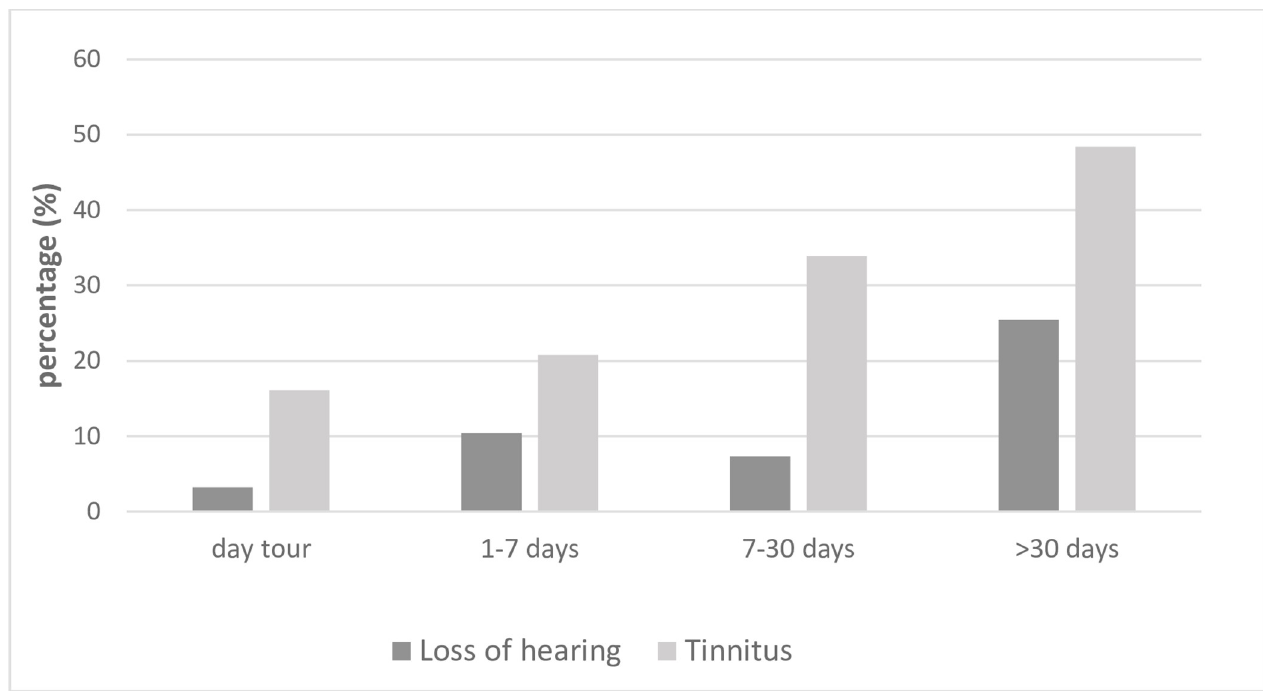
Fig 3. Participants who had experienced or been diagnosed with loss of hearing or tinnitus according to length of sea